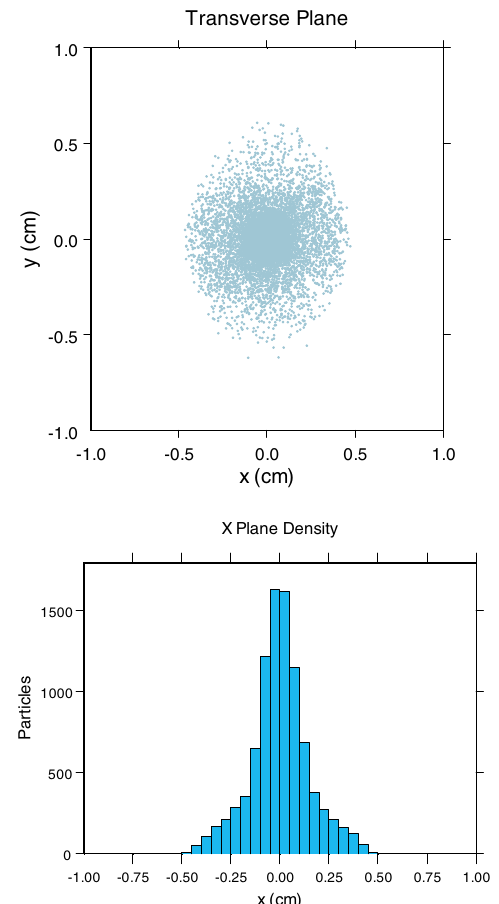
FIG. 5. (Color) Symmetric